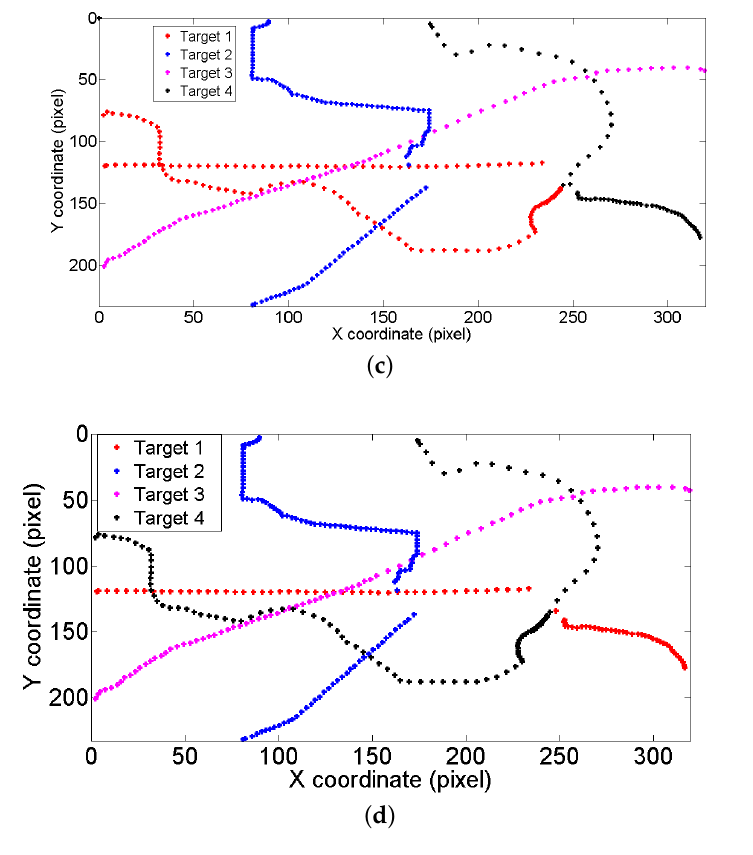
Figure 8. Tracking trajectories on a synthetic image sequence. ( a ) Ground truth; ( b ) for the GM-PHD tracker; ( c ) for the CPGM-PHD tracker; ( d ) for our tracker.